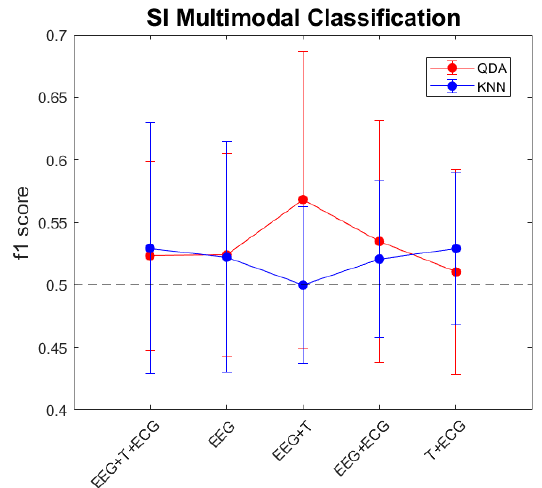
Figure 5. F1 scores for the SD approach at the different multimodal classifications performed with the KNN and QDA classifiers.